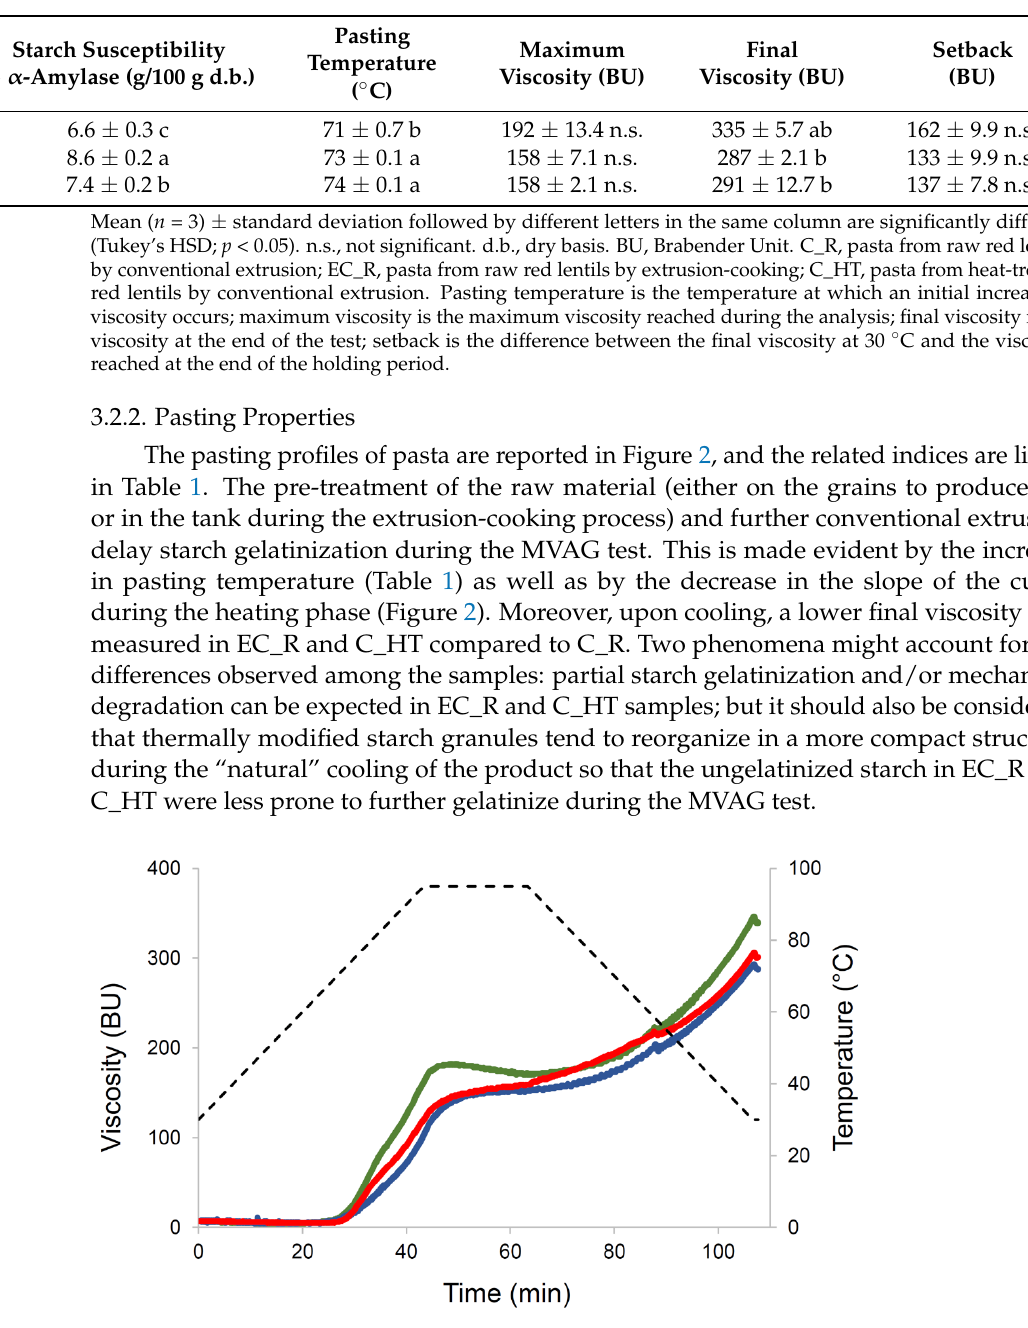
Figure 2. Pasting profile of pasta from red lentils. The green line is pasta from raw red lentils by conventional extrusion (C_R); the blue line is pasta from raw red lentils by extrusion-cooking (EC_R); the red line is pasta from heat treated red lentils by conventional extrusion (C_HT); the dotted black line is temperature profile. BU is Brabender Unit.